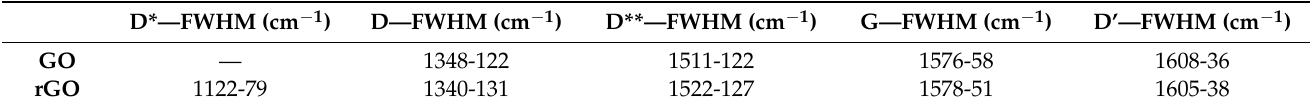
Table 1. Position and full-width at half maximum (FWHM) of peaks detected in GO and rGO in the region from 1000 to 2000 cm − 1 . The FWHM was obtained using Lorentzian